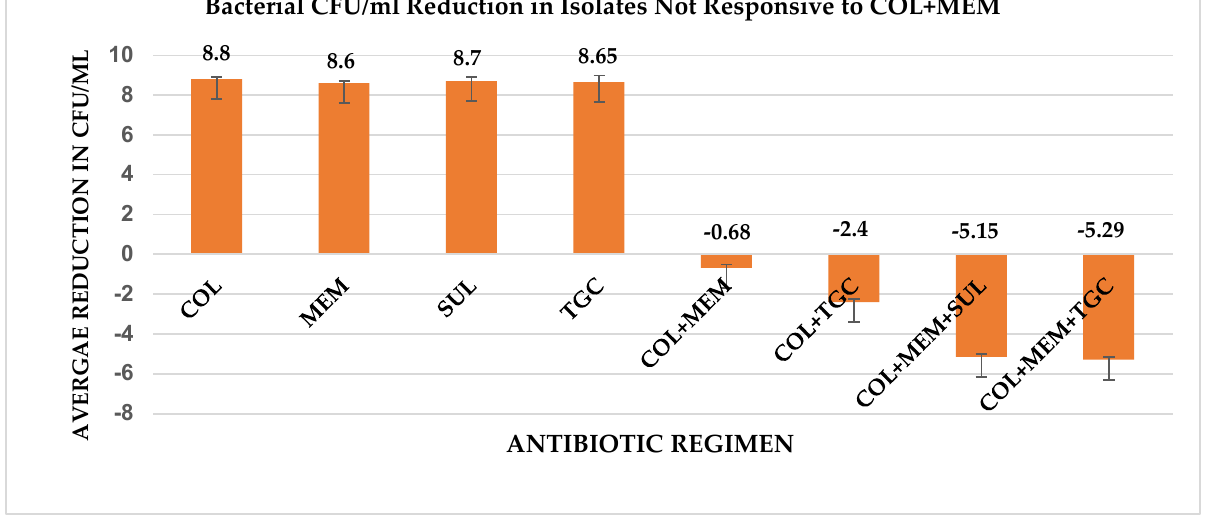
Figure 2. Graphical representation of the decline in bacterial CFU/ml with the use of the triple combinations in the 5 isolates that did not respond to COL+MEM. All TKA experiments, for each respective isolates, were completed in duplicate, and the error bars represent the standard deviation of the mean.